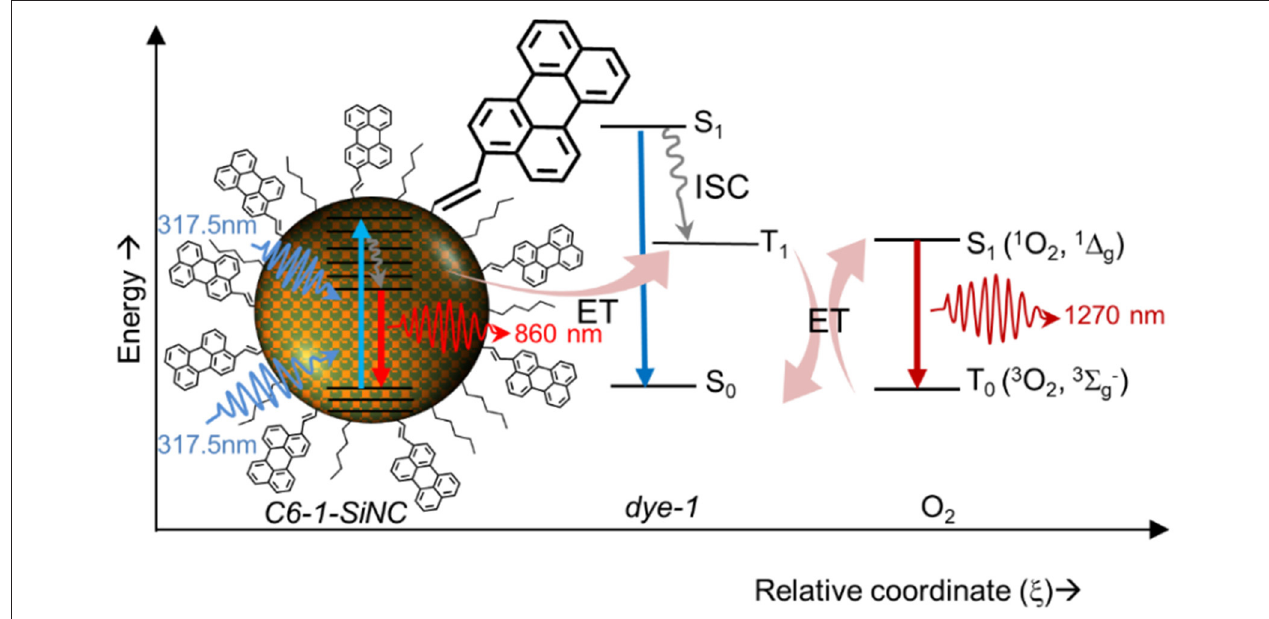
FIGURE 5 | Schematic showing photosensitization of 1 O 2 with SiNCs using the attached dye as transmitter for the excitation energy.